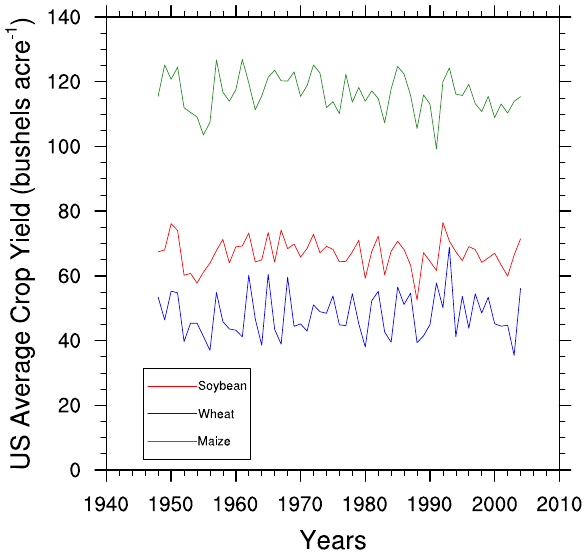
Fig. 7. Simulated average US crop yields (bu acre − 1 ) for maize, wheat, and